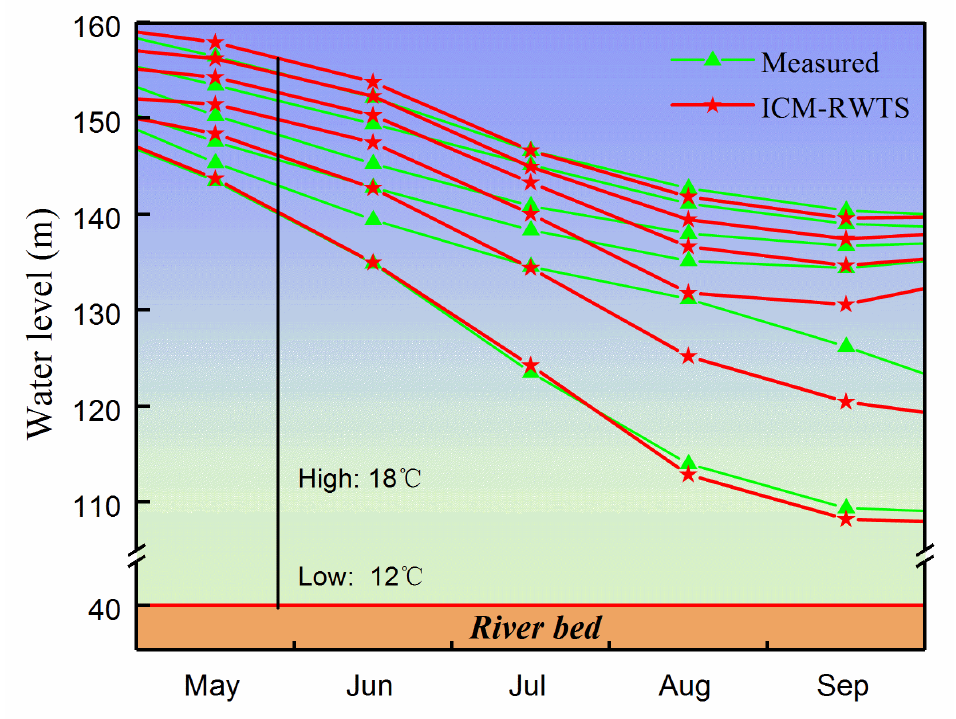
Figure 9. Comparison of water temperature isolines between the measured results and the computed results from ICM-RWTS.